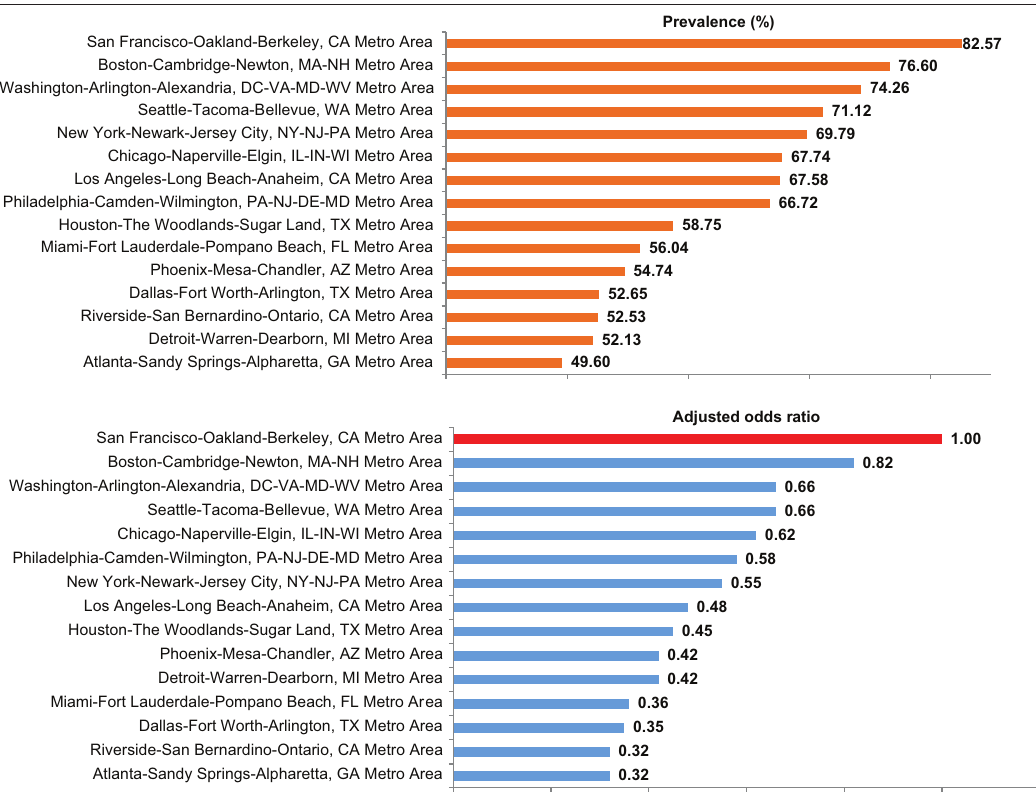
Figure 1: Prevalence 1 and Adjusted 2 Odds Ratios for COVID-19 vaccination among children aged 5-17 years in 15 largest Metropolitan Statistical Areas (MSAs), United States, December 2021 - April 2022 (N=28,156). 1 Prevalence rates of childhood COVID-19 vaccination for all MSAs were significantly lower than the rate for San Franciso-Oakland MSA at p<0.01. 2 Adjusted by logistic regression for age, gender, race/ethnicity, marital status, education, household income, recent household job loss, employment status, insurance status, and COVID-19 diagnosis, and COVID-19 vaccination status. The adjusted odds ratio for Boston MSA was not statistically significant at p<0.01. All other MSAs had significantly lower odds ratios, indicating lower adjusted vaccination prevalence compared with San Francisco-Oakland MSA. Source: Data derived from December 2021 – April 2022 Household Pulse